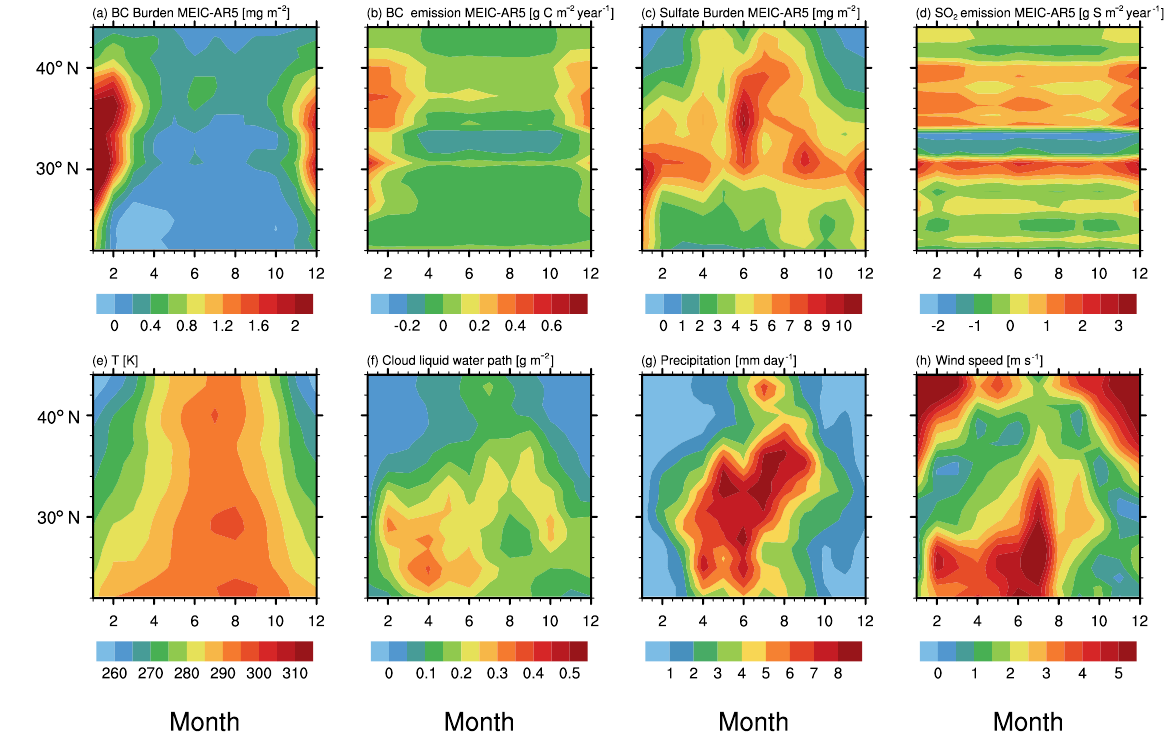
Figure 11. The seasonal variations of longitudinal-average (100–124 ◦ E) differences of (a) BC burden, (b) BC emission, (c) sulfate aerosol burden, and (d) SO 2 emission between the CAM5 simulations using the MEIC emission and the AR5 emission with identical meteorological variables of (e) temperature, (f) relative humidity at the surface, (g) precipitation, and (h) horizontal wind speed over eastern China in